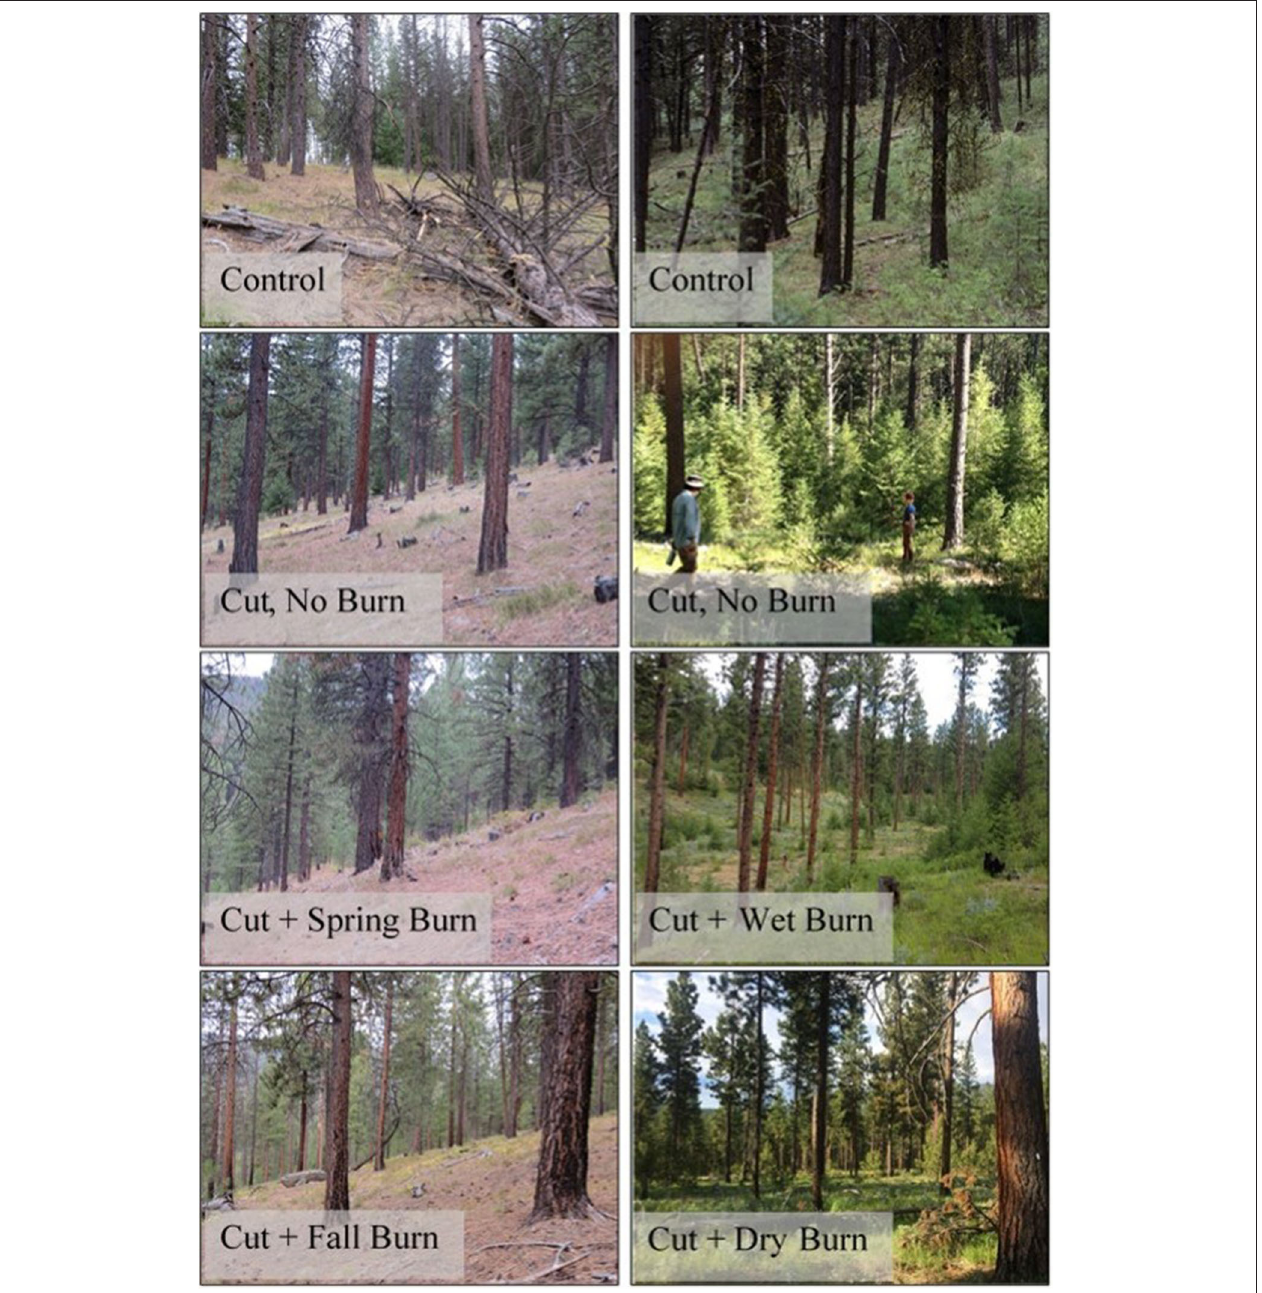
FIGURE 9 | Examples of treatments included in the Thinning ( left panel) and Retention Shelterwood ( right panel) ∼ 22 years post-treatment. See Lutes et al. (2020) for timeseries of all photopoints.